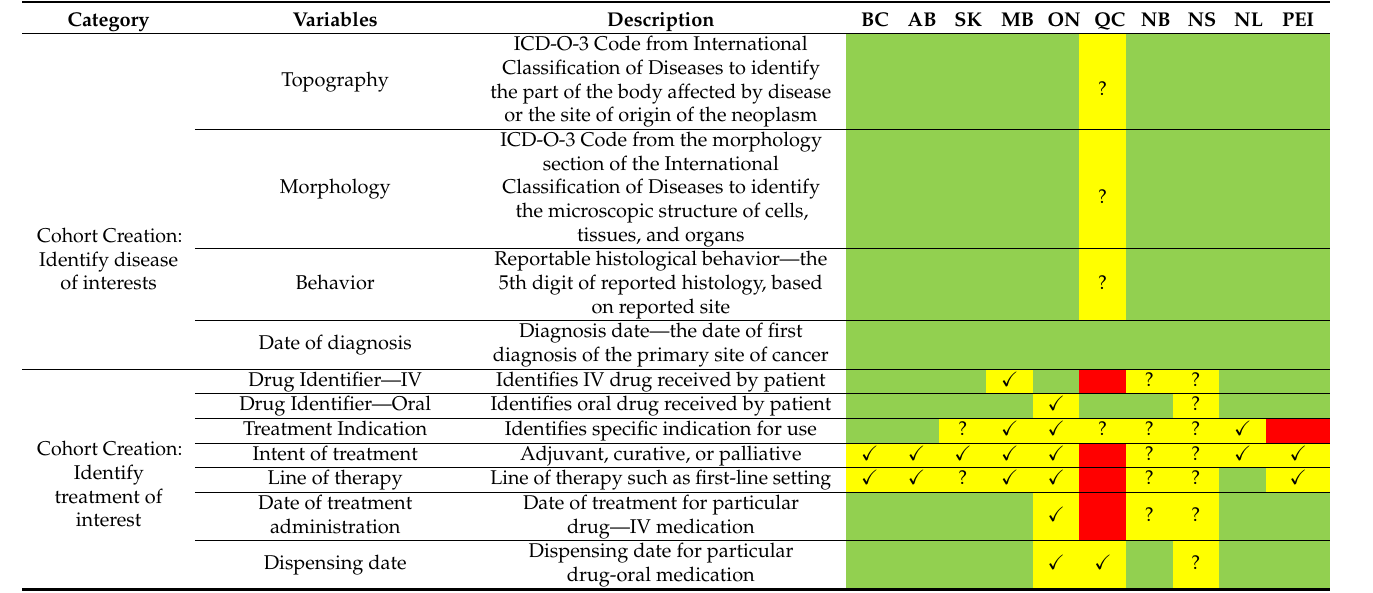
Table 4. Expanded Cancer RWD